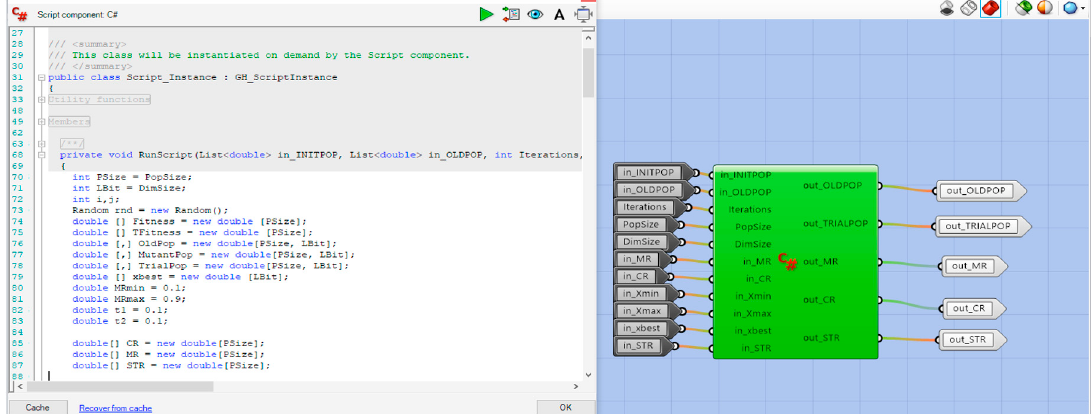
Figure 5. Example cluster implementation for self-adaptive differential evolution algorithm with ensemble of mutation strategies (jEDE) component.